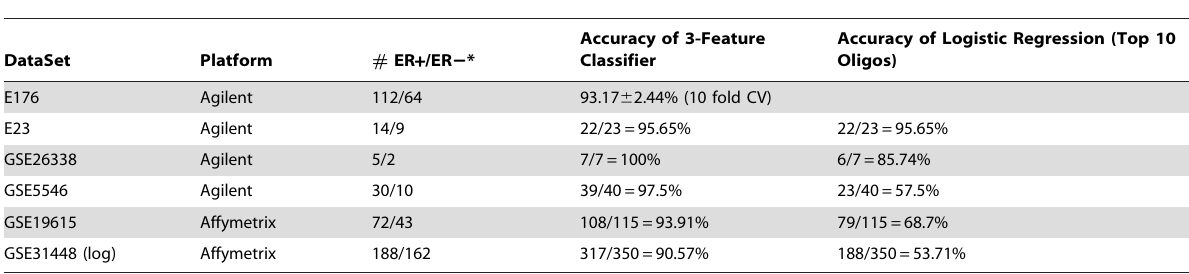
Table 2. Accuracy for our 3-feature classifier, over various datasets.